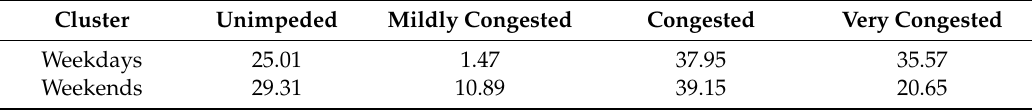
Table 7. Comparison of tra ffi c conditions between weekdays and weekends